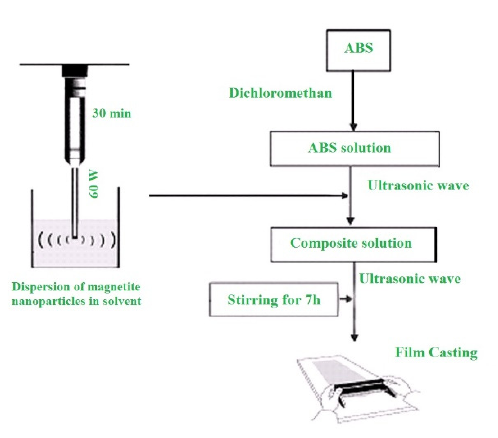
Fig. 1. Preparation of ABS-Fe